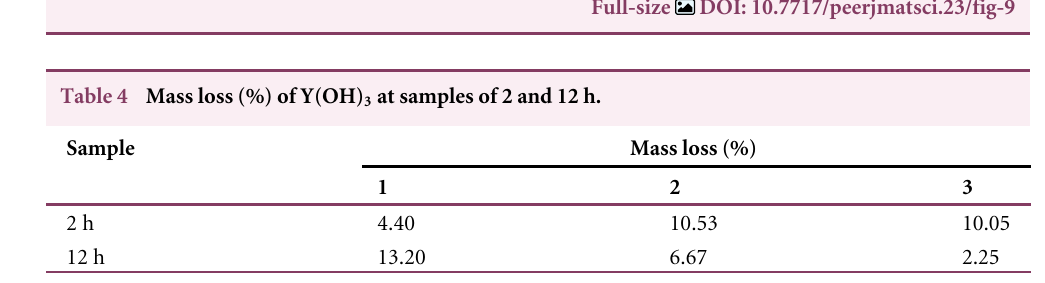
Full-size DOI: 10.7717/peerjmatsci.23/fig-9